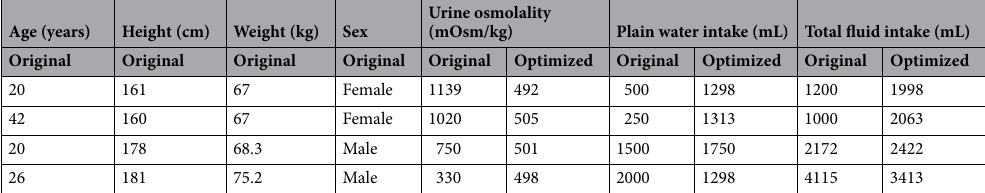
Table 2. Personalized advice for some individuals of the test set.